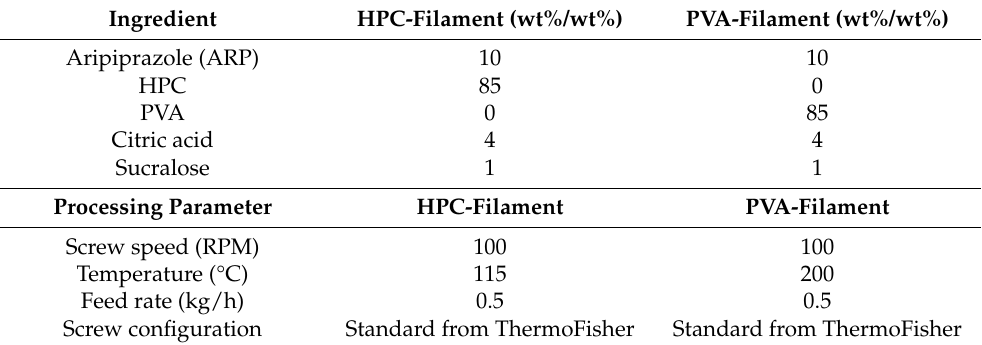
Table 1. Composition and processing parameters of filaments prepared using the hot-melt extrusion technology.